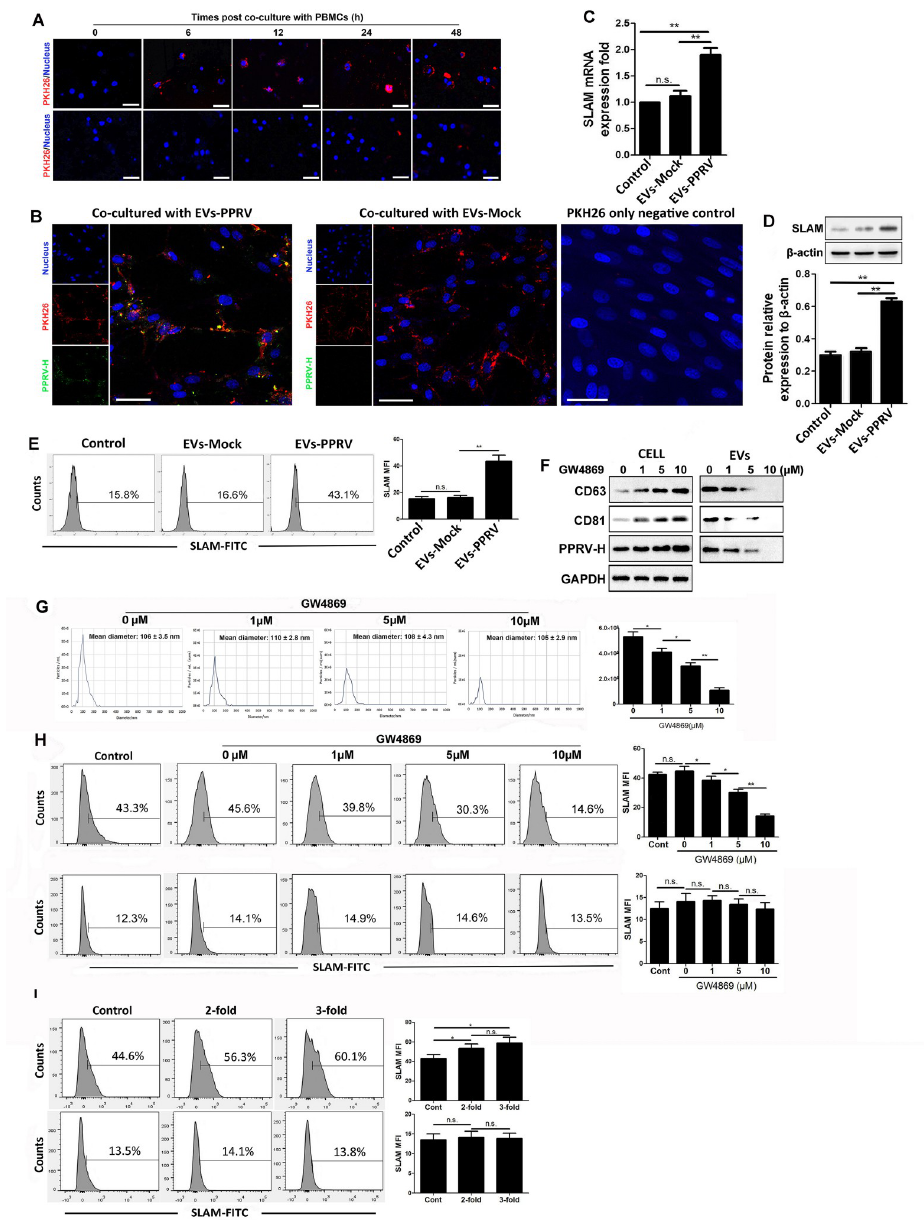
Fig 3. PPRV associate extracellular vesicles enhance SLAM expression in the recipient cells. (A) PKH26-labeled EVs internalization by goat PBMCs ( top ); PKH26-labeled PBS were used as PKH26-only negative control ( bottom ) (Scale bar = 30 μ m). (B) EVs isolated from PPRV-infected cells (EVs-PPRV) or from Mock-infected cells (EVs-Mock) were labeled with PKH26, and co-cultured with naive goat PBMCs for 48 h, immunofluorescent staining was performed to analysis the internalization of EVs and PPRV H protein expression in the recipient cells. PKH26-labeled PBS were used as PKH26-only negative control (Scale bar = 30 μ m). (C, D, E) Equal quantities of EVs-PPRV or EVs- Mock were respectively co-cultured with the same amount of naive goat PBMCs for 48 h, and SLAM expression levels in the recipient cells were determined by RT-PCR (C), Western blot (D), and flow cytometry (E). Untreated goat PBMCs were used as the blank control. (F, G) Goat PBMCs were infected with PPRV at an MOI of 1 for 1 h and then maintained in medium containing indicated concentrations of GW4869 for 48 h. Then, the cells and the EVs isolated from the supernatants were subjected to Western blot for CD63, CD81, and PPRV H protein expression (F), and EVs were also subjected to NTA analysis(G). (H) Equal quantities of goat PBMCs infected with PPRV (MOI = 1) or Mock infected for 1 h and then maintained in medium containing indicated concentrations of GW4869 for 48 h. Then, the EVs from PPRV-infected cells ( top ) or Mock-infected cells ( bottom ) were respectively incubated with naive goat PBMCs that have the same amount of EVs-producing cells for 48 h and subjected to flow cytometry for